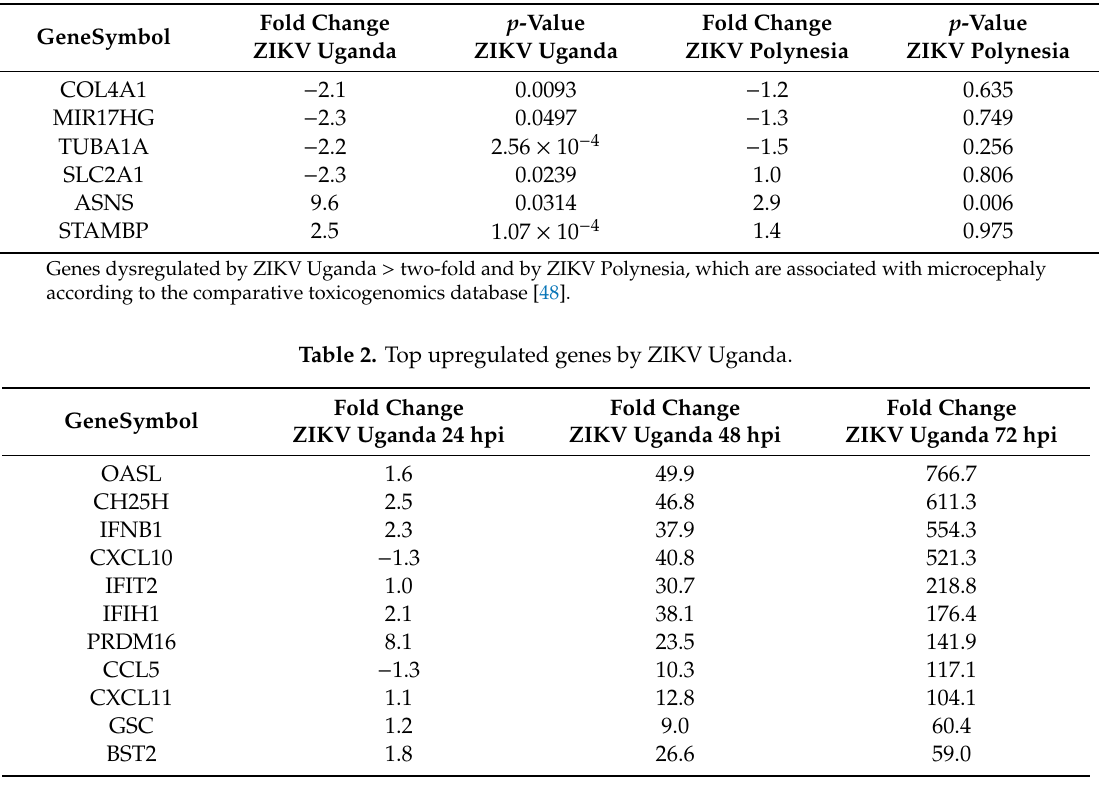
Table 1. Comparative toxicogenomics database screening.